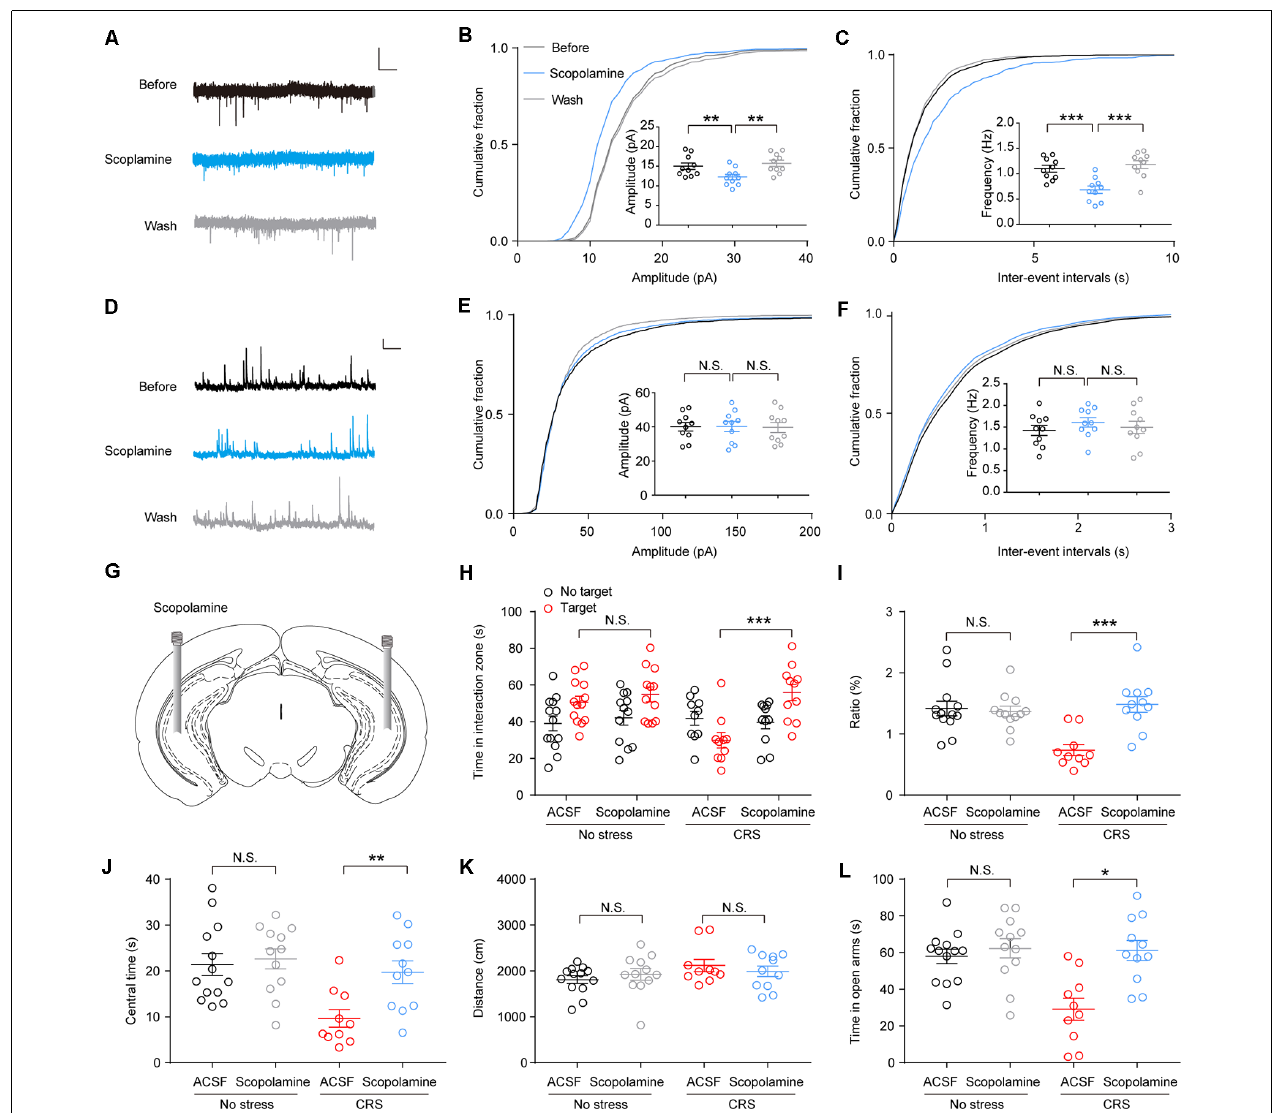
FIGURE 4 | Scopolamine reverses the enhanced spontaneous excitatory postsynaptic currents (sEPSCs) in vHPC neurons and rescues CRS-induced mouse social avoidance and anxiety-like behaviors. (A) Representative sEPSC traces before, during, and after wash of scopolamine. Scale bar: 10 pA, 1 s. (B) Cumulative distribution of sEPSC amplitudes and average amplitudes. One-way ANOVA/least square difference (LSD) post hoc test. F (1.619,14.57) = 18.99, p = 0.0002. Before vs. scopolamine, t (9) = 4.369, p = 0.0036. Wash vs. scopolamine, t (9) = 5.028, p = 0.0014. (C) Cumulative distribution of sEPSC inter-event intervals and average frequencies. One-way ANOVA/LSD post hoc test. F (1.283,11.55) = 30.79, p < 0.0001. Before vs. scopolamine, t (9) = 5.376, p = 0.0009. Wash vs. scopolamine, t (9) = 6.081, p = 0.0004. (D) Representative spontaneous inhibitory postsynaptic current (sIPSC) traces before, during, and after wash of scopolamine. Scale bar: 10 pA, 1 s. (E) Cumulative distribution of sIPSC amplitudes and average amplitudes. One-way ANOVA/LSD post hoc test. F (1.878,16.9) = 0.009277, p = 0.9882. Before vs. scopolamine, t (9) = 0.0377, p > 0.9999. Wash vs. scopolamine, t (9) = 0.1537, p > 0.9999. (F) Cumulative distribution of sIPSC inter-event intervals and average frequencies. One-way ANOVA/LSD post hoc test. F (1.839,16.55) = 0.5085, p = 0.5954. Before vs. scopolamine, t (9) = 0.9347, p = 0.7487. Wash